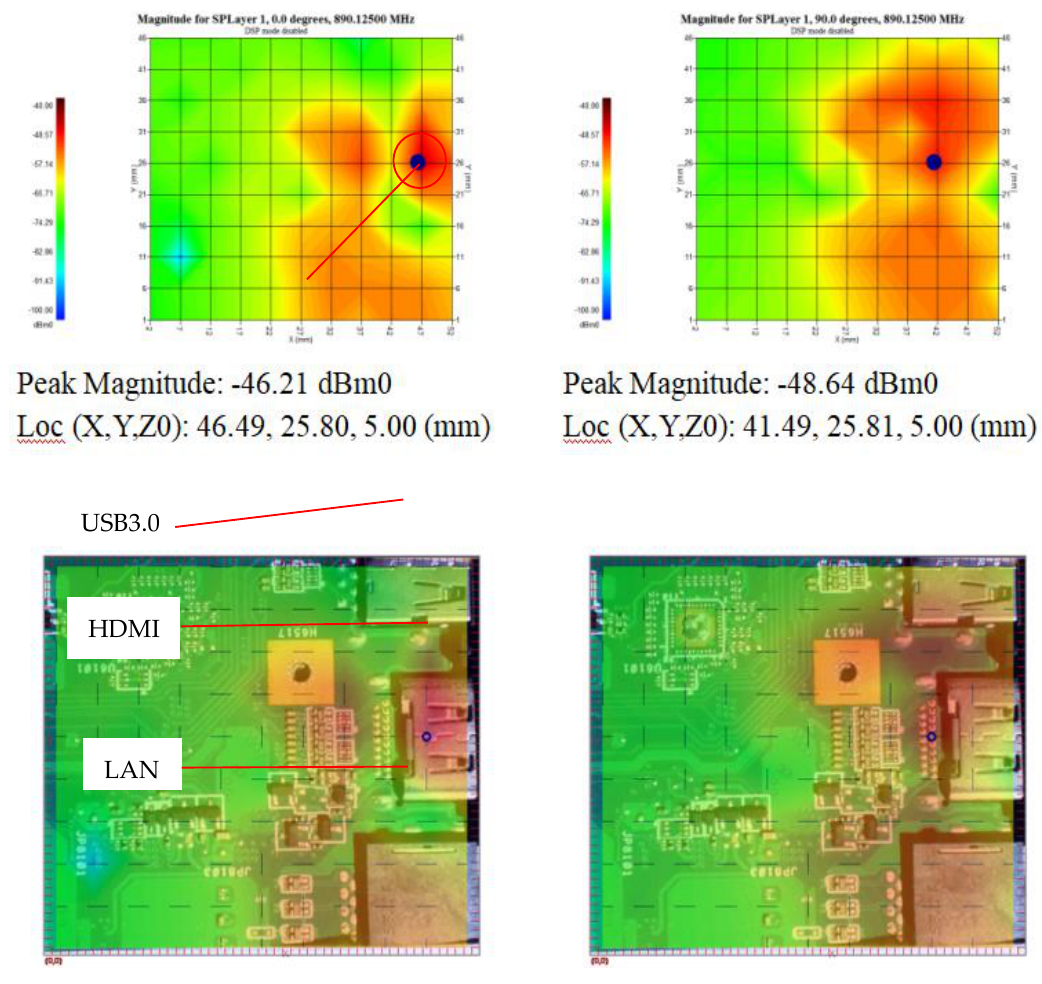
Figure 16. HDMI field intensity distribution map of PCB initial version.